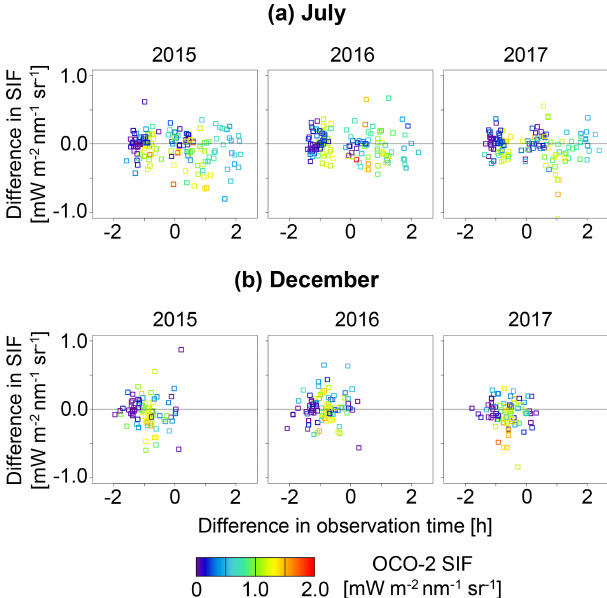
Figure 7. Relationship between the difference in SIF (GOSAT – OCO-2) and the difference in local time of the observation for 2015 to 2017: (a) July; (b) December. Each symbol represents a 5 ◦ × 10 ◦ grid box.